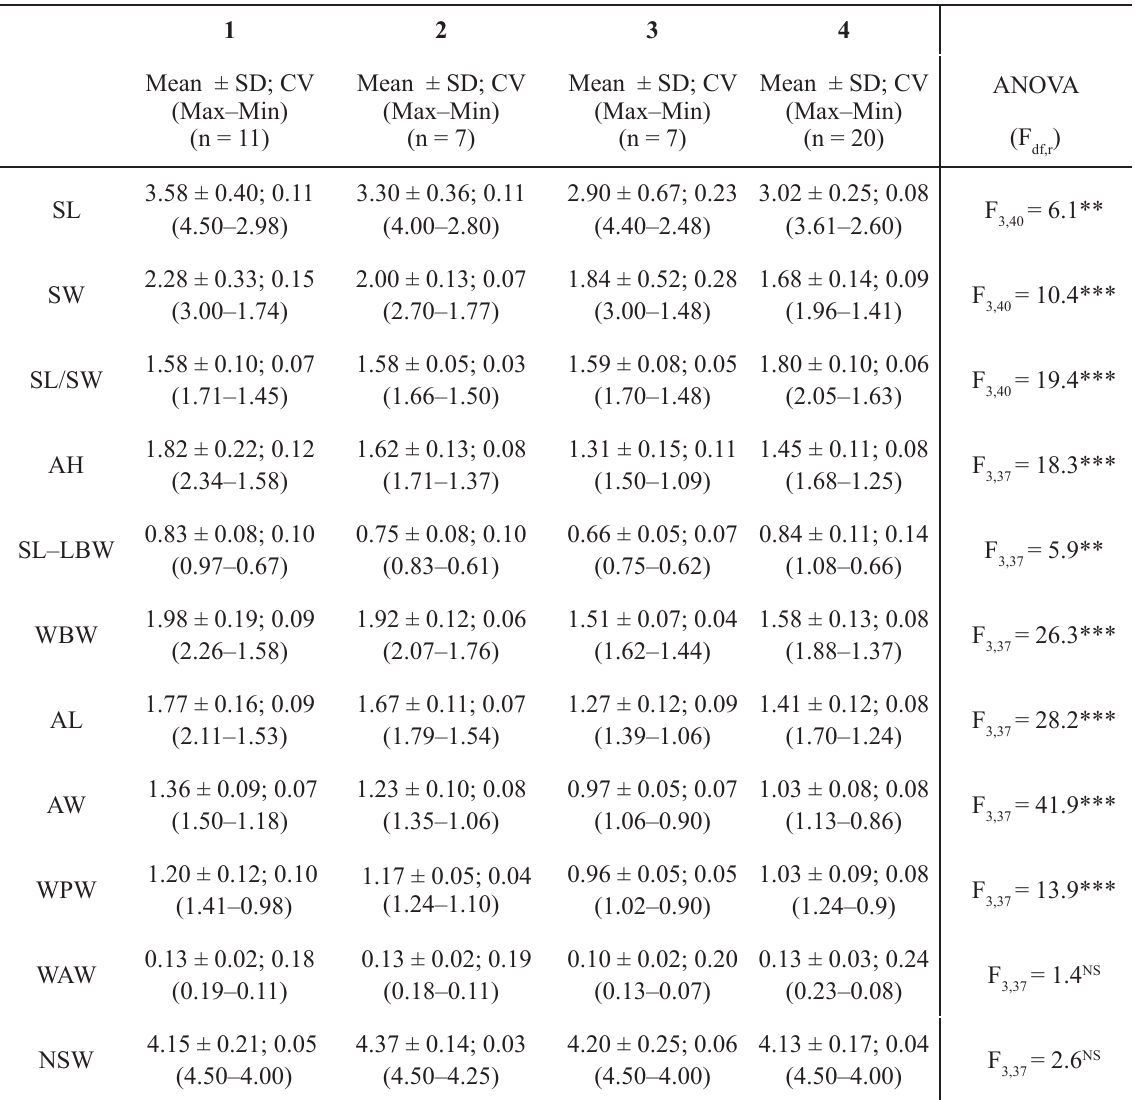
Table 2. Shell measurements (in mm) of the species: 1 . Intermaria zagrosensis (Glöer & Pešić, 2009). 2 . Intermaria kermanshahensis (Glöer & Pešić, 2009). 3 . Persipyrgula saboori (Glöer & Pešić, 2009). 4 . Shadinia terpoghassiani (Shadin, 1952). ANOVA results are shown through effect size F, degrees of freedom (df), residuals (r) and the resulting significance (p–value: *** when 0; ** when 0.001; * when 0.01; NS = no